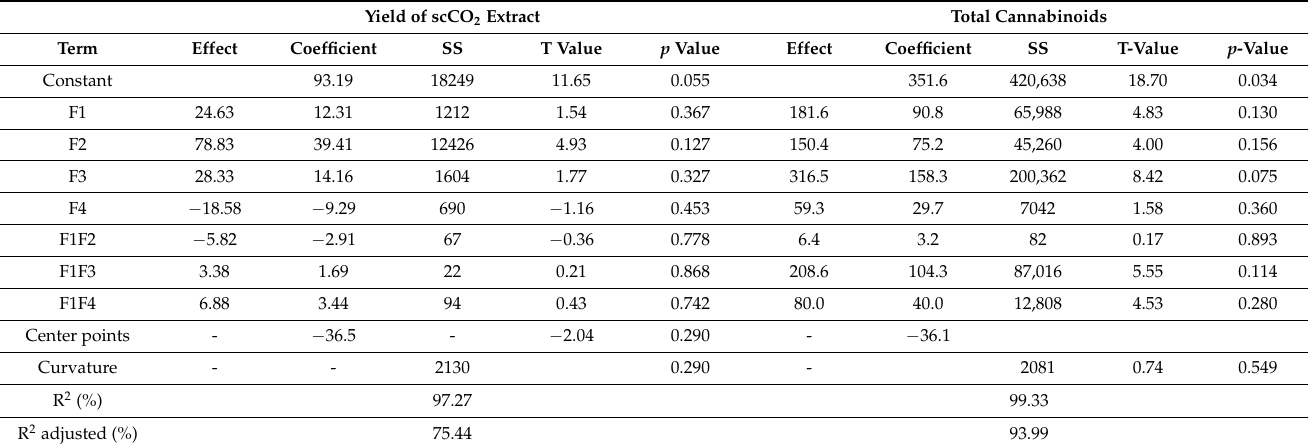
Table 4. Estimated coefficient and effects for the processing of supercritical carbon dioxide (scCO 2 ) extract yield and total